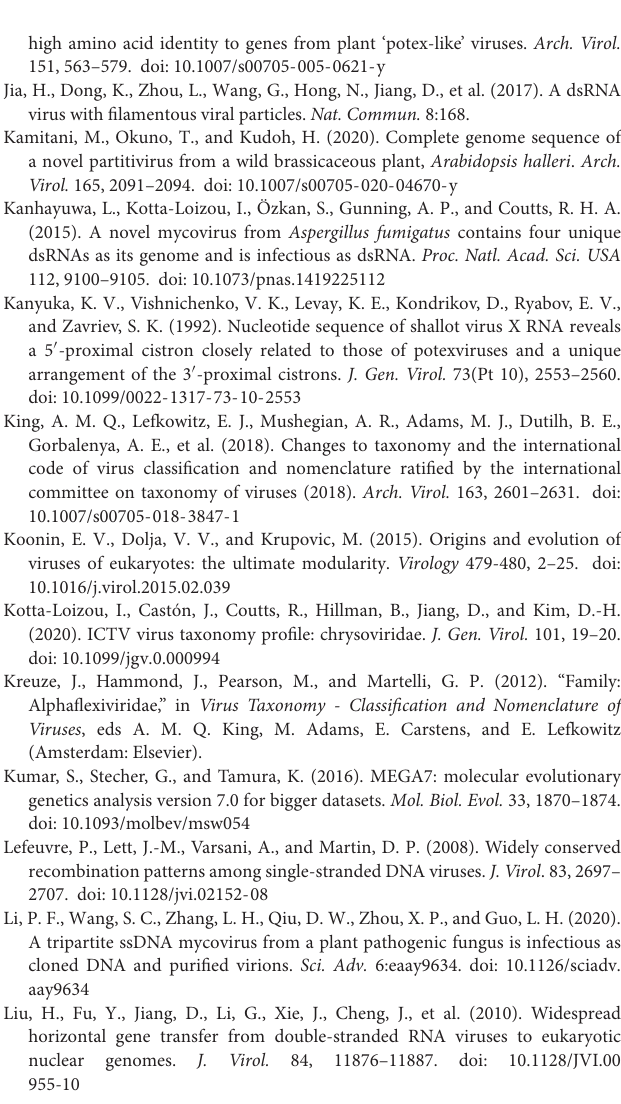
indicated above and below, respectively. Supplementary Figure 2 | Phylogenetic tree based on the amino acid sequences of RdRp of BdNV2–4 and its related viruses. BdNV2–4 are indicated by black circle. Supplementary Figure 3 | Immunoblot analysis and titer quantification of a polyclonal antibody against BdBV1 CP. (A) Immunoblot of viral preparations in different sucrose gradients of strain L153-29 and L153 using the antibody against BdBV1 CP (PAb-P5). (B) Titer quantification of PAb-P5 by indirect ELISA against the CP from viral preparations using PAb-P5 diluted from 500- to 512,000-fold. P/N, ratio of the absorbance values of the positive sample (BdBV1-infected strain L153) against the negative sample (control strain JNT1111) at a wavelength of 450 nm. Supplementary Figure 4 | Genome comparisons of BdBV1 and type species of different genera in the family Alphaflexiviridae . Block regions represent replicase (blue), movement (yellow), coat (red), nucleic acid binding (gray), and unknown (white)